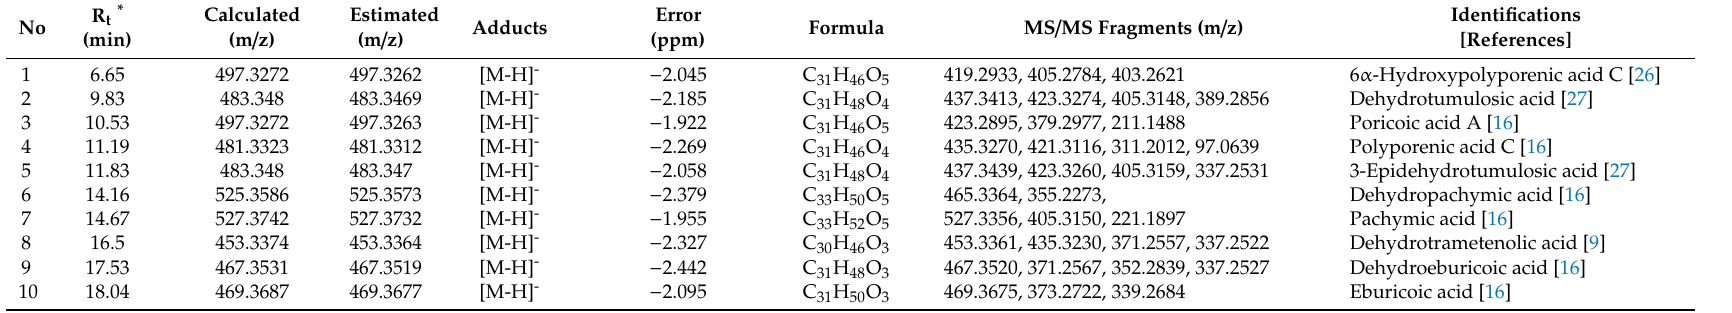
Table 1. Phytochemical constituents of PC as analyzed by UHPLC-MS /